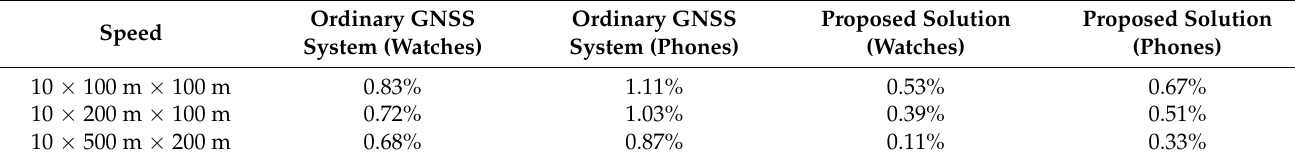
Table 2. Speed accuracy